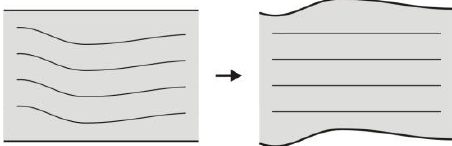
Figure 1. Epipolar rectification for ADS strips. Left: level-0 data with curved epipolar lines. Right: level-1 projection, resul- ting in piecewise straight epipolar geometry.